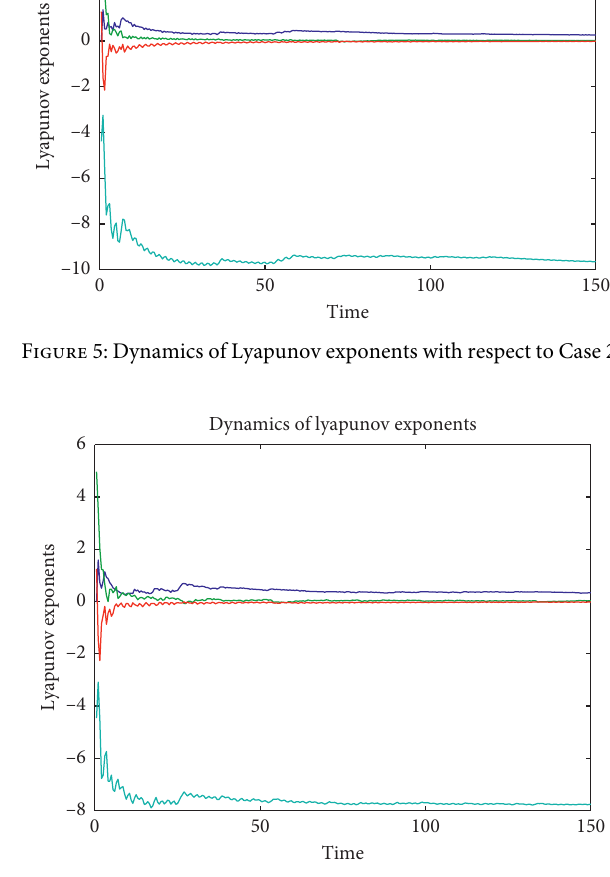
Figure 6: Dynamics of Lyapunov exponents with respect to Case